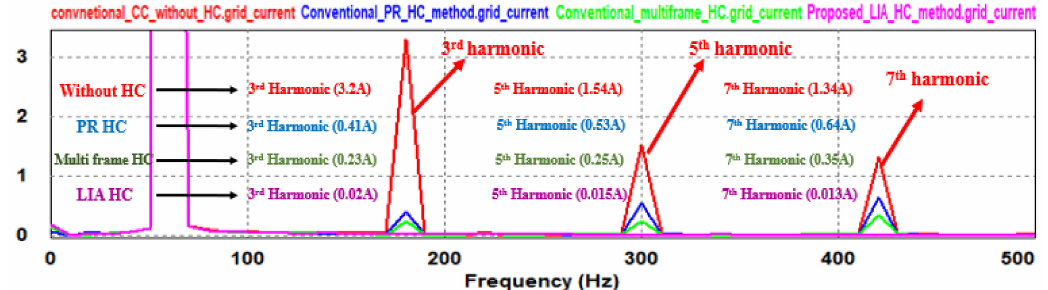
Figure 10. FFT comparison of grid currents between conventional and proposed harmonic compensation